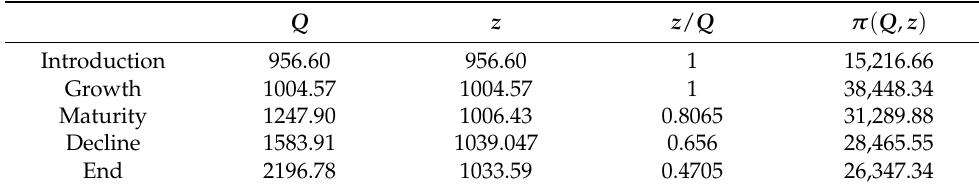
Table 7. The results along the lifecycle.